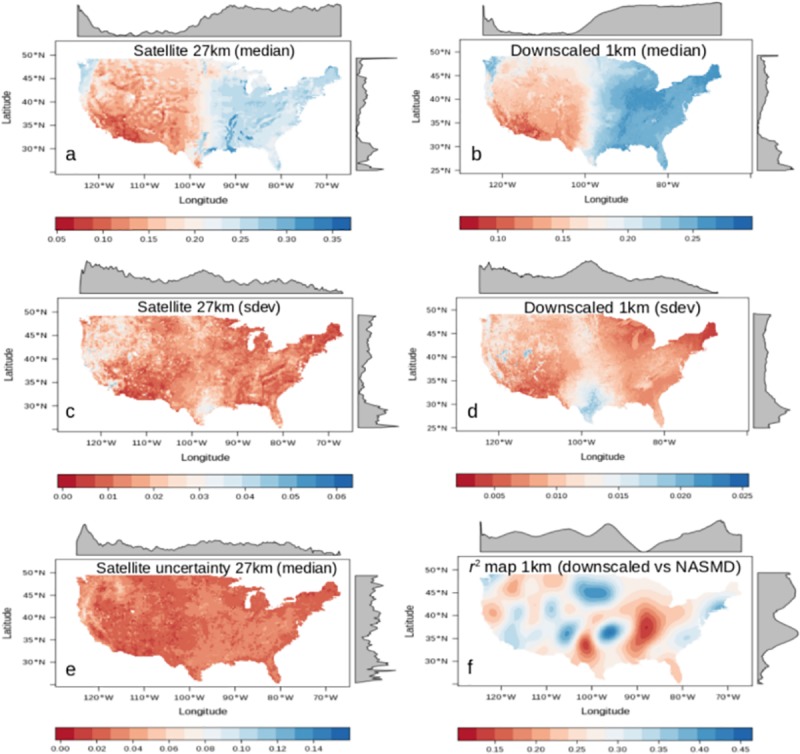
Comparison of the original (27km grids) and the downscaled (1km grids) soil moisture products.Median (a, b) and standard deviation (c, d, sdev) values of satellite soil moisture and downscaled soil moisture values (1991–2016). Uncertainty reported by the ESA-CCI soil moisture (e) and the explained variance map (r2) between field data and downscaled soil moisture (f).